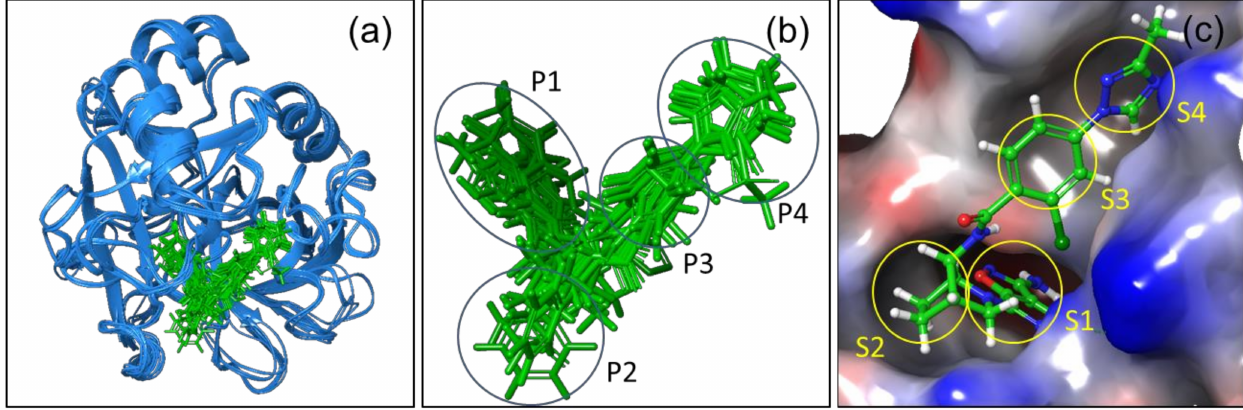
Figure 1. ( a ) The structural alignment of 12 co-crystallized structures of FIXa and FXa. ( b ) All the ligands in the co- crystallized structures are also aligned on same binding pocket with the same binding mode. ( c ) The binding mode of the co-crystallized ligand in the binding pocket with electrostatic potential surface representation with negative (red color), neutral (white color) and positive (blue color) patches on the surface. S1, S2, S3, S4 are the subsites of the long binding site and P1, P2, P3, P4 are the corresponding regions on the ligands that occupies those